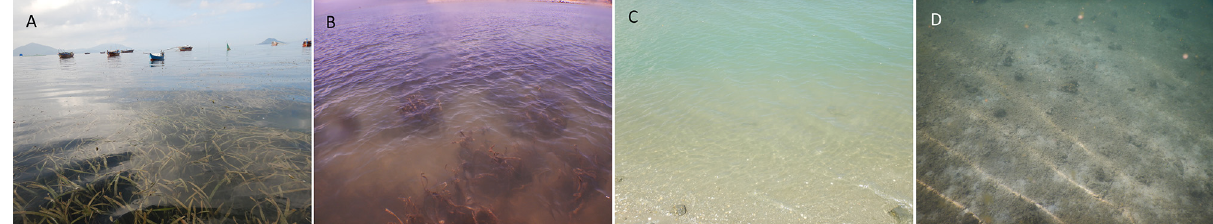
Fig. 2. Different shallow substrata at TL, A = shallow dense seagrass beds, B = shallow patchy seagrass beds, C = shallow muddy sand, and D = deeper water with sand substratum. See Figure 1 for the abbreviation of locations.